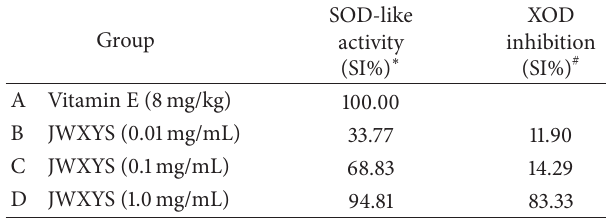
∗ Measured using the cytochrome C reduction test. # Measured using the XOD inhibition test. Vitamin E was used as the positive control. SI: superoxide